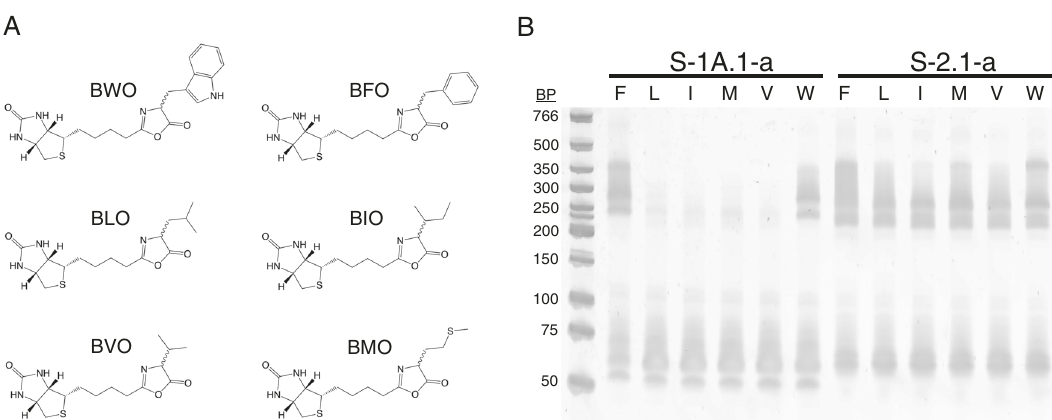
Fig. 1 Aminoacylation activity of two ribozymes with BXO substrates. A Biotinyl aminoacyl oxazolones (BXO) used in this study: tryptophanyl (BWO), phenylalanyl (BFO), leucyl (BLO), isoleucyl (BIO), valyl (BVO), and methionyl (BMO). B Aminoacylation activity of two ribozymes (S-1A.1-a, the center of Family 1A.1, and S-2.1-a, the center of Family 2.1) with BXO substrates analyzed by streptavidin gel shift on native PAGE (X = F, L, I, M, V, or W, as indicated; see Methods for details). Reactions were conducted for 90 min at 500 μ M BXO. The reacted RNA is detected by its slower migration through the gel due to complexation with streptavidin. This experiment was conducted once; also see Fig. S11. Since a single reactive site was identi fi ed (Fig. S12), multiple bands on native gels may be caused by the presence of multiple conformers or streptavidin oligomers. MW markers are the Low Molecular Weight Ladder (dsDNA) from NEB. Structures were drawn using ChemDraw 19.0. Source data are provided as a Source Data fi